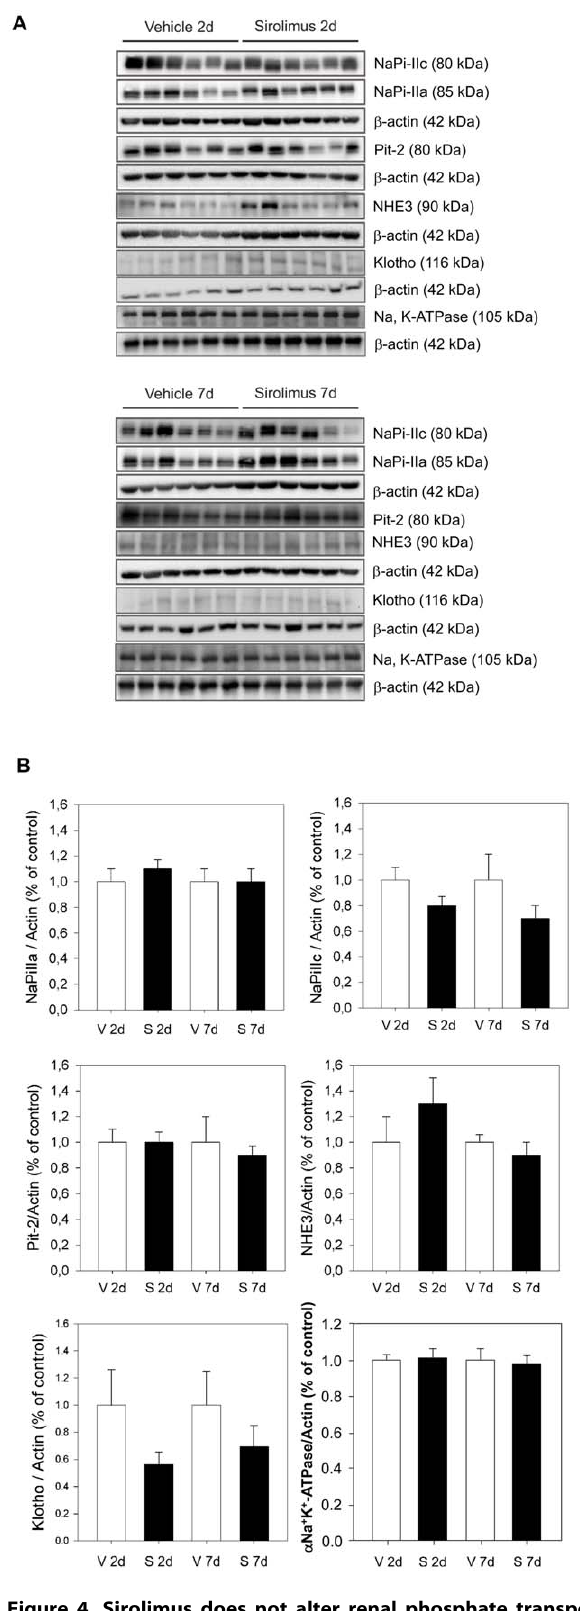
Figure 4. Sirolimus does not alter renal phosphate transpor- ters. Sirolimus treatment for two and seven days does not alter protein expression levels of NaPi-IIa, NaPi-IIc, Pit-2, klotho and NHE3 in the brush border membrane. Brush border membranes or total